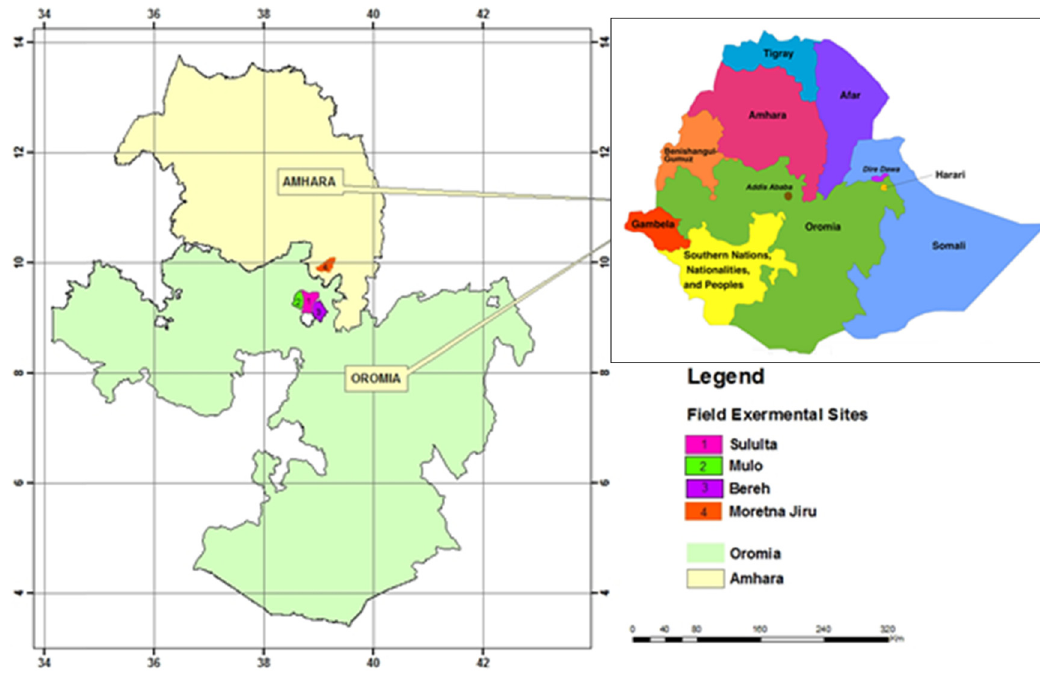
Figure 1: Location map of experimental sites in Oromia and Amhara – Ethiopia.